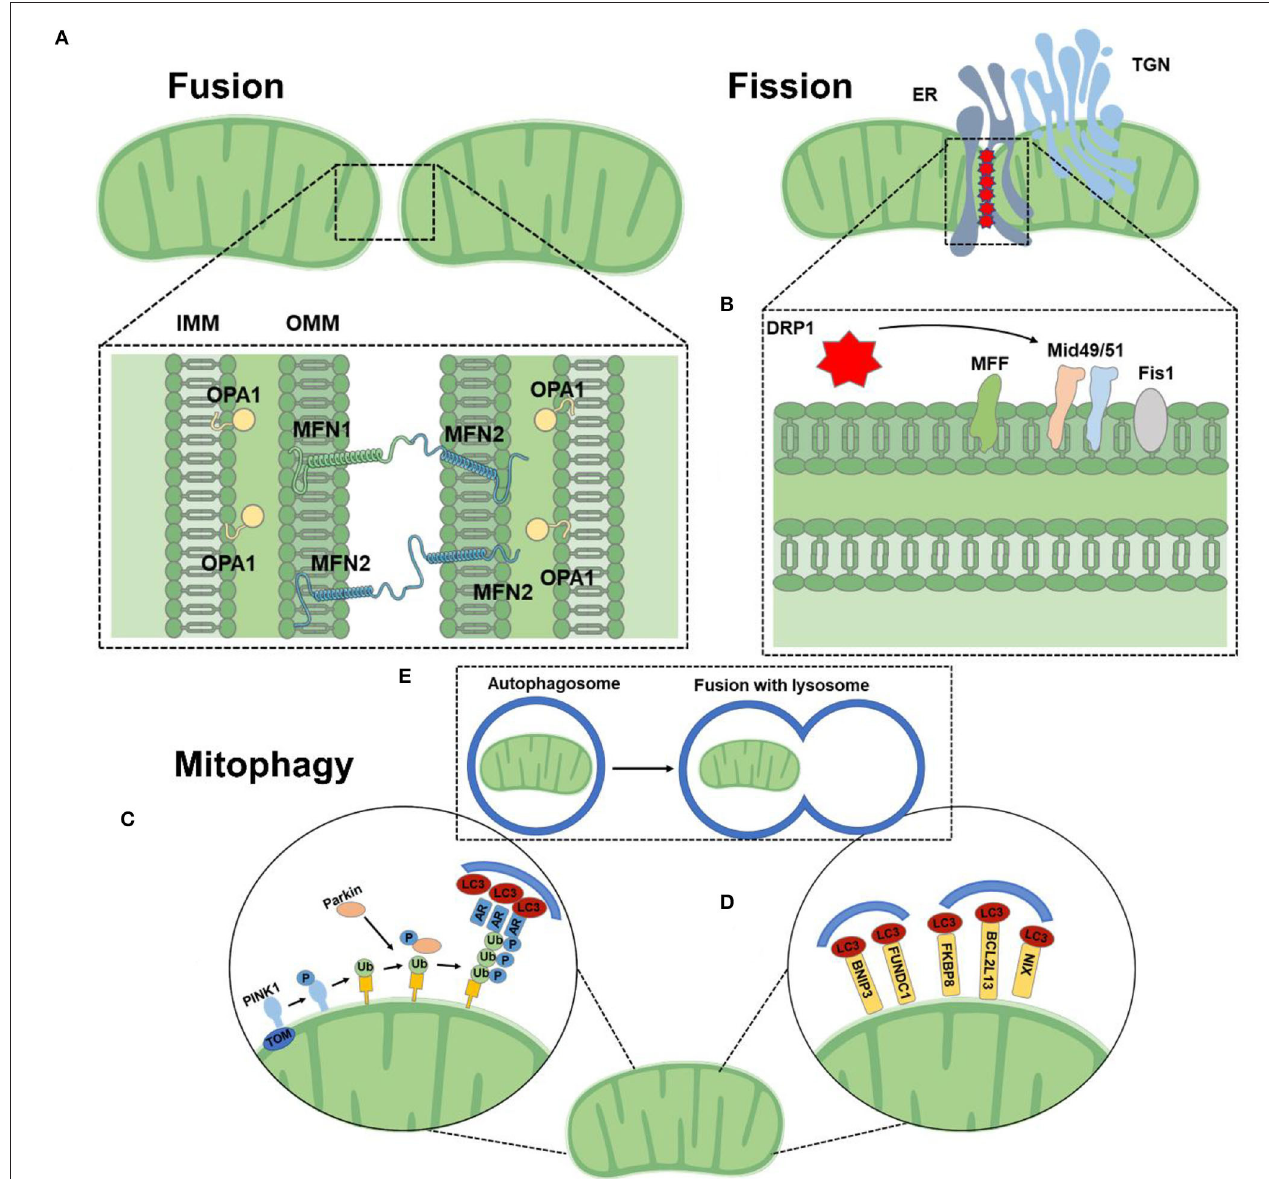
FIGURE 2 | Mitochondrial function. (A) Mitochondrial fusion is mediated by homo-and heterotypic interactions between MFN1 and MFN2 at the OMM and OPA1 at the IMM. (B) DRP1 binds to its receptors at the OMM at sites of contact with the ER. (C) The PINK1/Parkin-dependent pathway: under stress conditions, PINK1 was stable on OMM, which promoted the recruitment of Parkin. Parkin ubiquitizes several outer membrane components. The polyubiquitin chain is then phosphorylated by PINK1 as a “eat me” signal for the autophagy mechanism. Autophagy receptors (AR) recognize phosphorylated polyubiquitin chains on mitochondrial proteins and initiate autophagosome formation by binding to LC3. (D) The PINK1/Parkin-independent pathway: mitophagy receptors, such as BNIP3, NIX, FKBP8, and FUNDC1 are located to directly interact with OMM and LC3 to mediate mitochondrial clearance. (E) Mitochondria are engulfed by autophagosomes, which fuse with lysosomes and catabolize